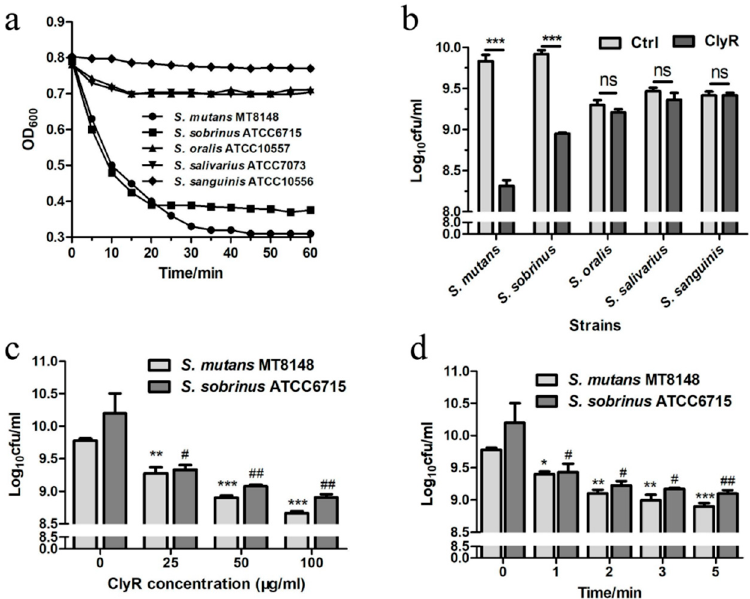
Figure 1. Activity of ClyR against oral microbes. ( a ) Activity of ClyR against common oral bacteria. S. mutans MT8148, S. sobrinus ATCC6715, S. oralis ATCC10557, S. salivarius ATCC7073, and S. sanguinis ATCC10556 were treated with 50 µ g/mL ClyR for 1 h; the Y-axis represents the bacteria